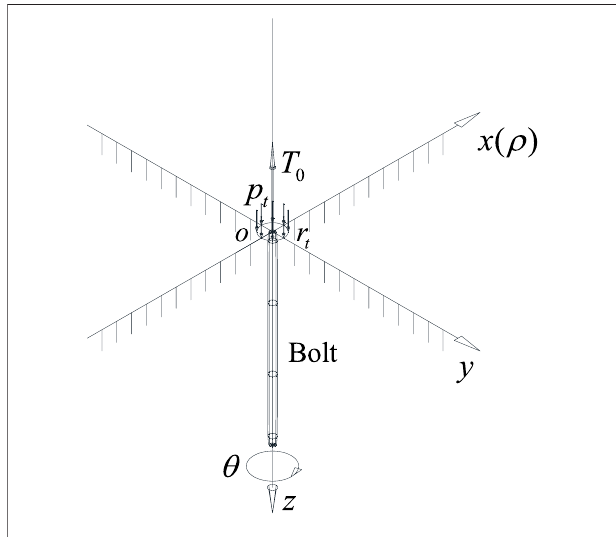
FIGURE 1 | Stress diagram of the bolt and surrounding